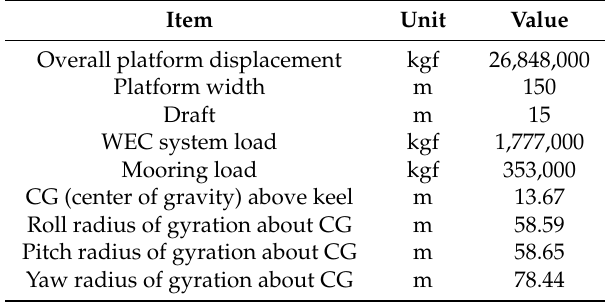
Figure 2. Submerged part of the platform including the multiple wave energy converters (WECs).